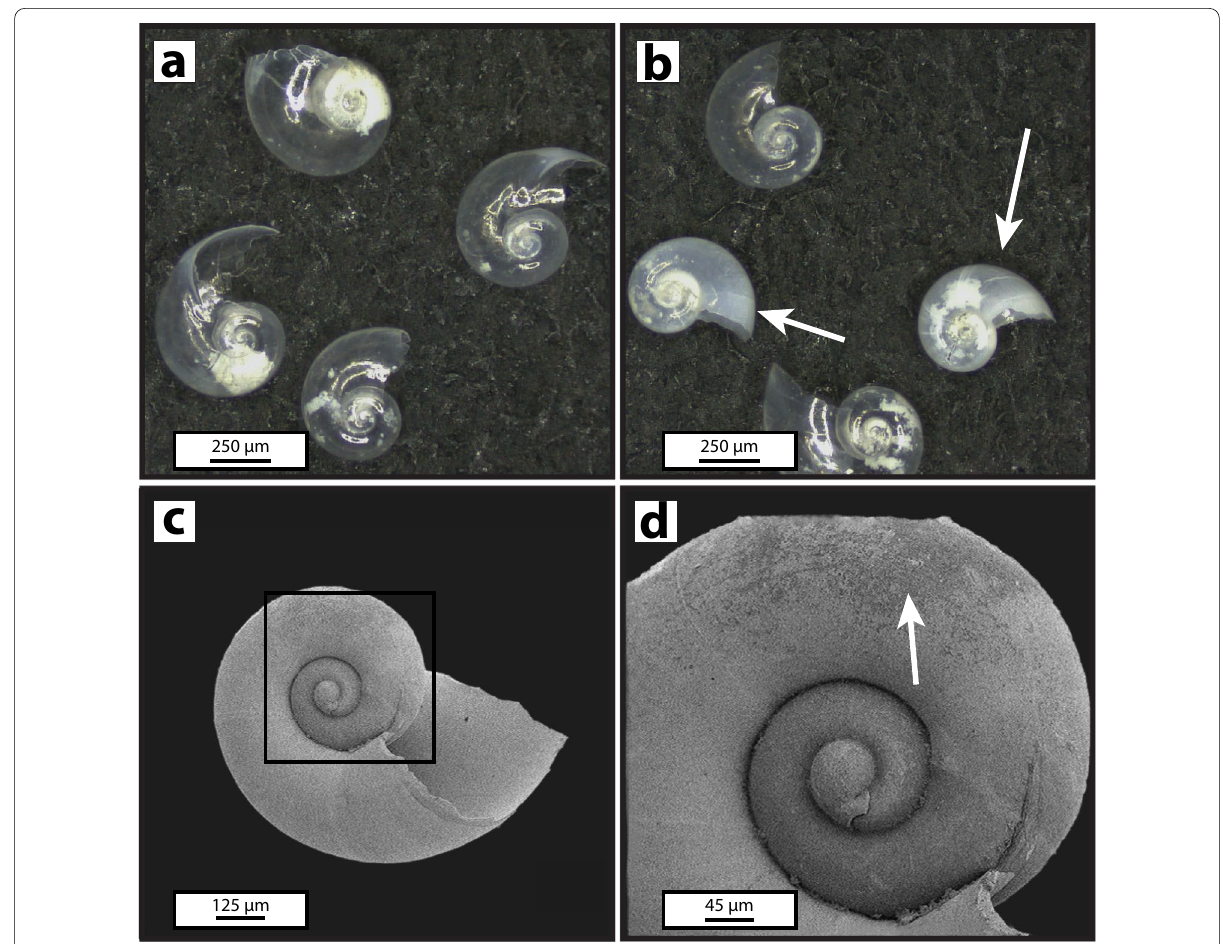
Fig. 4 Optical microscopy and SEM images of selected H. inflatus samples. ( a ) Most pteropods in the studied core material are very well preserved (LDX 0), including lustrous and transparent shells (Site U1463; 12 ka). ( b ) The preservation of some shells from Site U1463 (6–8 ka) exhibits slight = deterioration (LDX 0–1). Single shells partly have an opaque milky white color or a cloudy appearance (white arrow) (Site U1463; 7 ka). ( c ) SEM = image of a slightly corroded pteropod. The black square indicates the location of (d) (Site U1463; 7 ka). ( d ) Dissolution of a pteropod as evidenced by the rough surface of part of the shell (white arrow) (Site U1463; 7